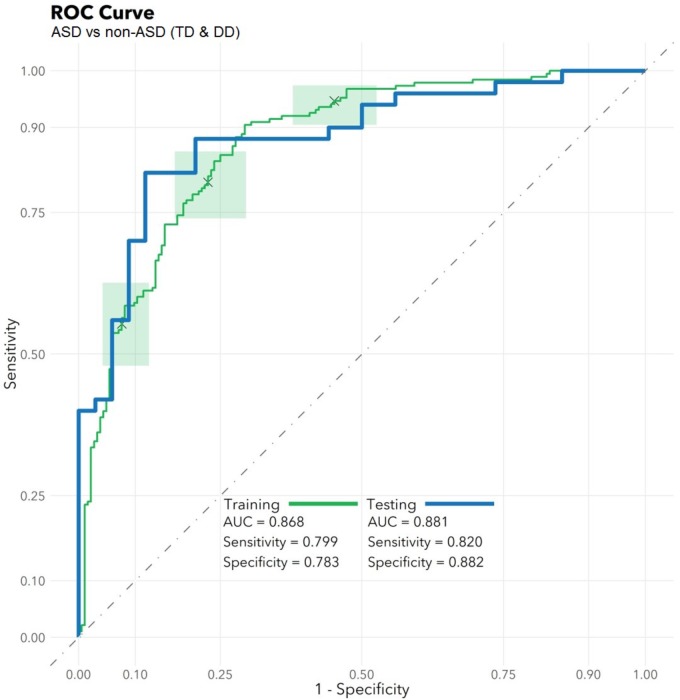
Algorithm Performance. In a training set (n = 372), a radial kernel support vector machine model used 32 salivary RNA features (comprising 11 miRNAs, 8 piRNAs, 1 snoRNA, and 12 microbial taxons) to differentiate 188 children with autism spectrum disorder (ASD) from 184 non-ASD peers with typical development (TD) or non-ASD developmental delay (DD), while controlling for participant medical and demographic features. Performance is displayed on the green receiver operator characteristic curve (area under the curve: 0.87; 95% CI: 0.86–0.88) as a function of varying the threshold of probability of ASD prediction. Green boxes indicate rectangular confidence regions with cross-validation. In a naïve test set (n = 84), the algorithm correctly identified 41/50 ASD, 18/21 TD, and 12/13 DD children [area under the curve (AUC): 0.88, blue/bold].